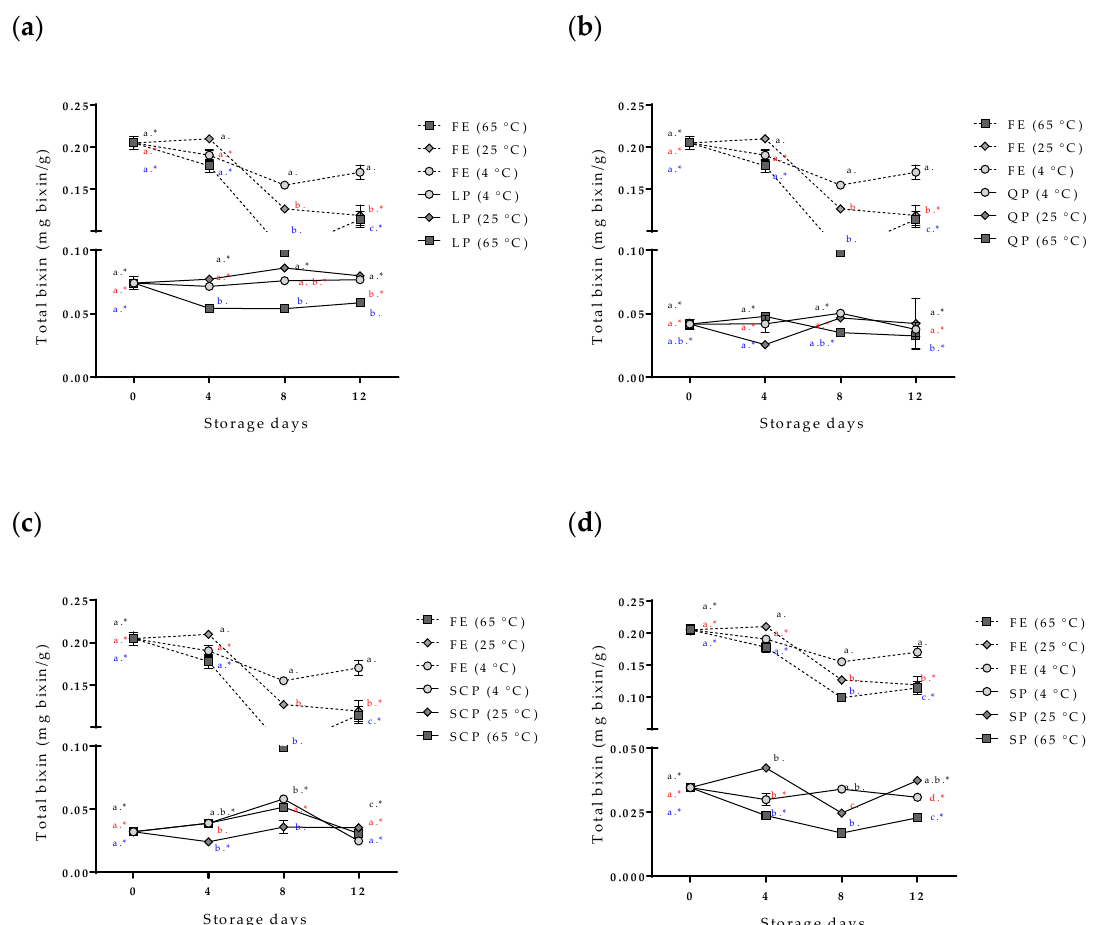
Figure 5. E ff ect of storage time and temperature of bixin isolated from the free and encapsulated annatto extracts. ( a ) Free and encapsulated extracts with lentil proteins, ( b ) free and encapsulated extracts with quinoa proteins, ( c ) free and encapsulated extracts with sodium caseinate, and ( d ) free and encapsulated extracts with soy proteins. FE: free extract, LP: lentil protein, QP: quinoa protein, SCP: sodium caseinate, SP: soy protein. Di ff erent superscript letters (a–c) within figure indicate significant di ff erences between storage days in the same sample ( p < 0.05) and samples marked with “ ∗ ” are not significantly di ff erent between the samples at same storage day ( p < 0.05). Both di ff erences according to Fisher’s least significant di ff erence (LSD-Fisher) test.